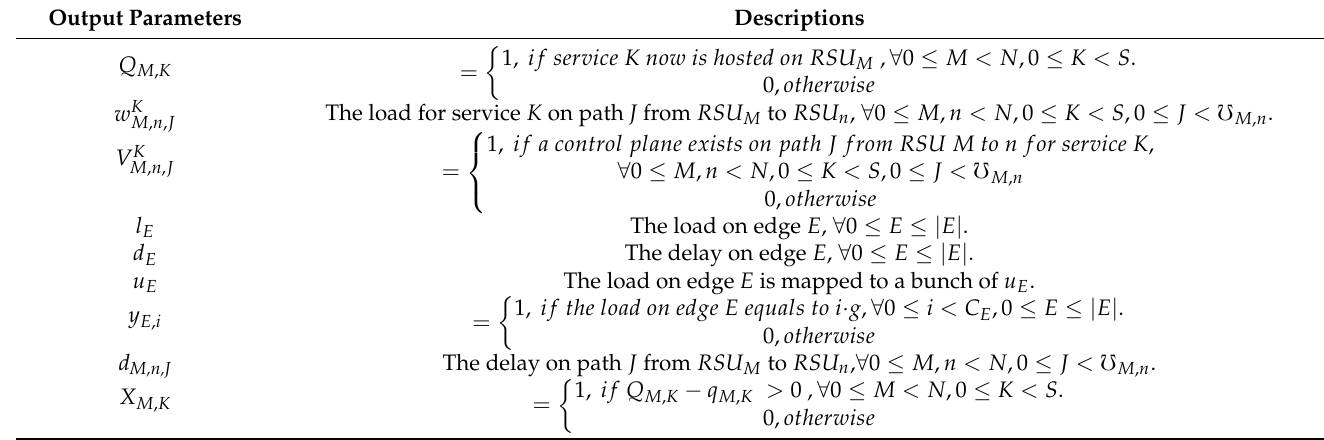
Table 2. Definitions for the output